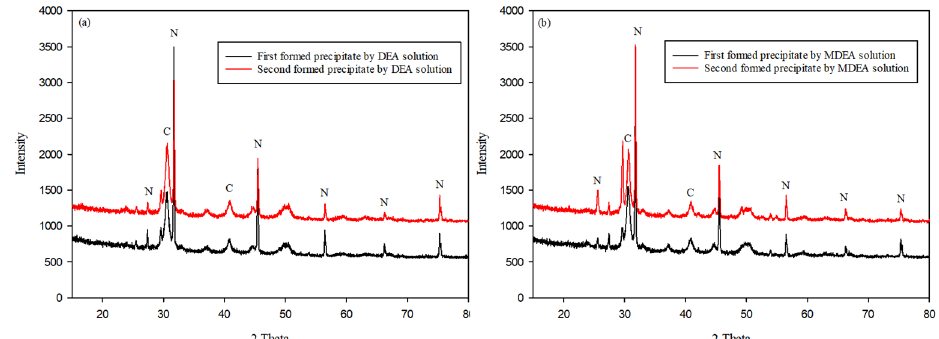
Figure 3. XRD results for precipitate formed in 5 wt % MEA solution with simulated seawater: ( a ) unwashed precipitate and ( b ) washed precipitate. (N: NaCl, C: calcite, V: vaterite, A: aragonite).